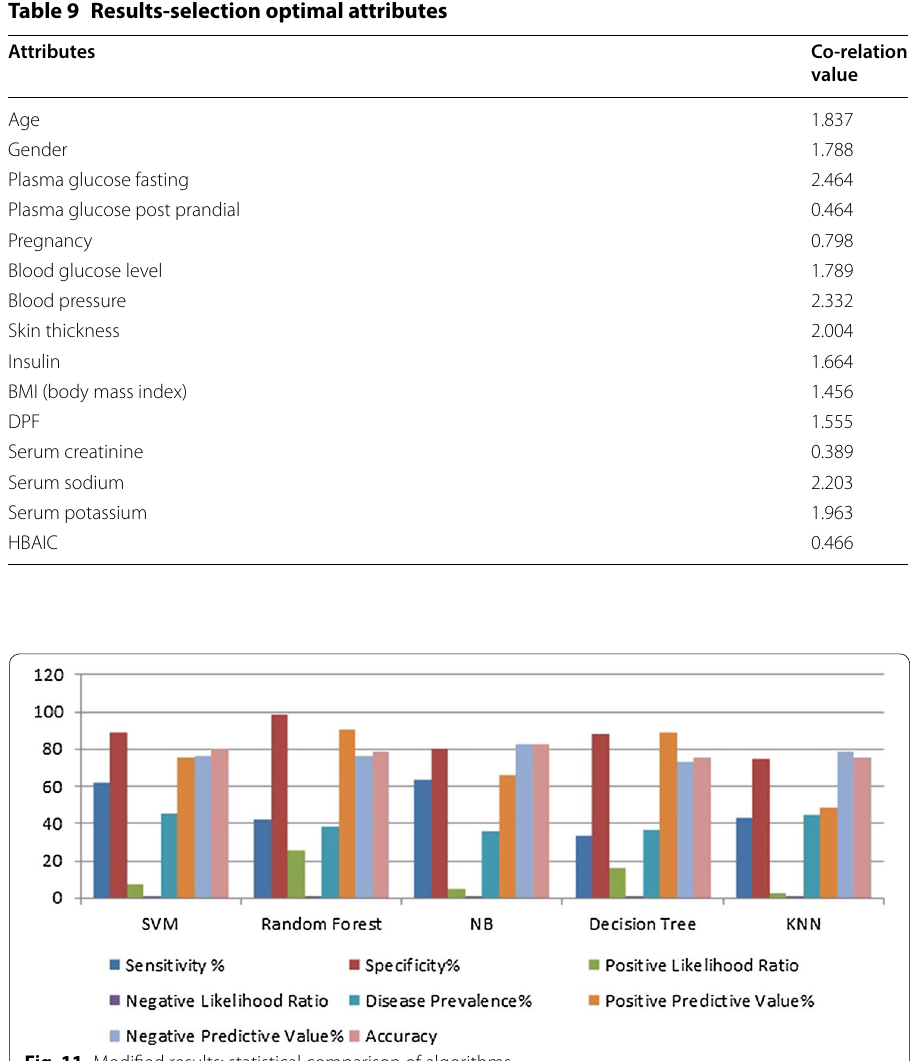
Fig. 11 Modified results: statistical comparison of